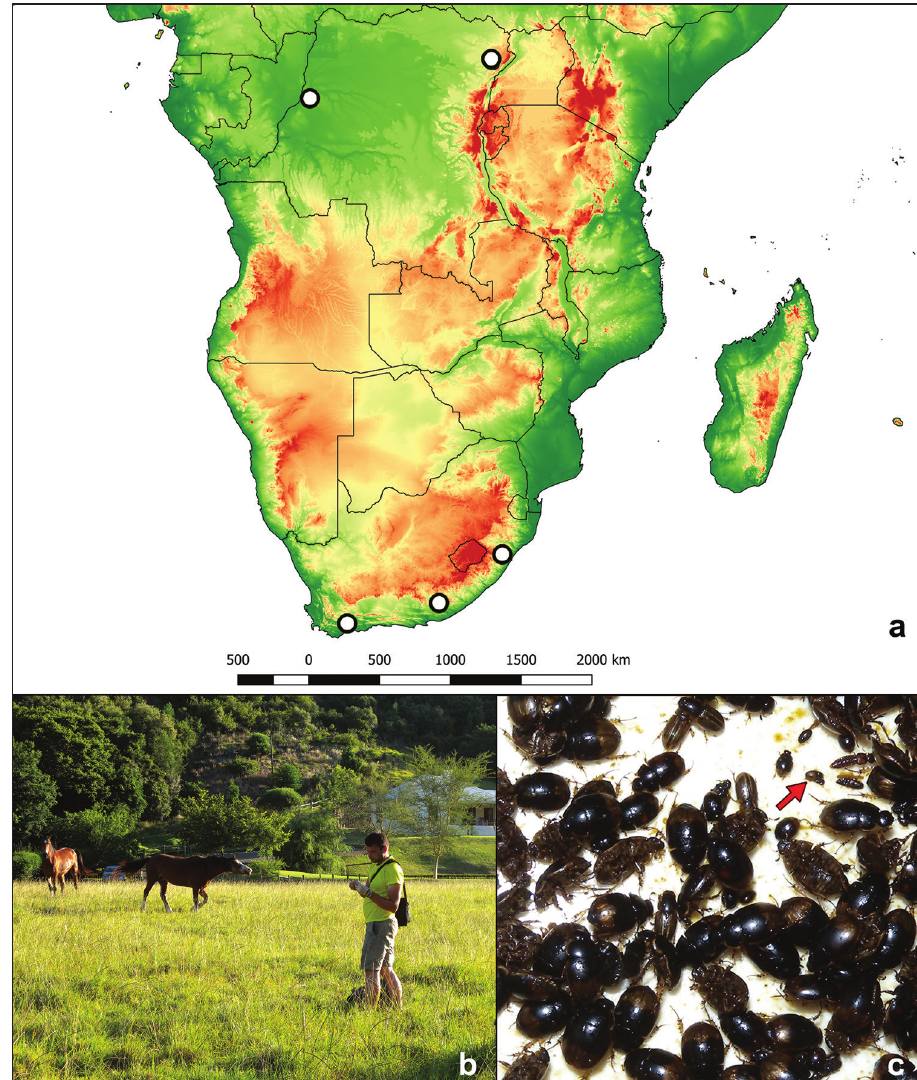
Figure 5. Evanesternum pulsatum (d’Orchymont) a distribution map b habitat collecting locality: Sum- merset Getaway Farm, Western Cape, Republic of South Africa c beetles collected from dung in Sum- merset Getaway Farm, Western Cape, Republic of South Africa. Red arrow is indicating an Evanesternum pulsatum (d’Orchymont)